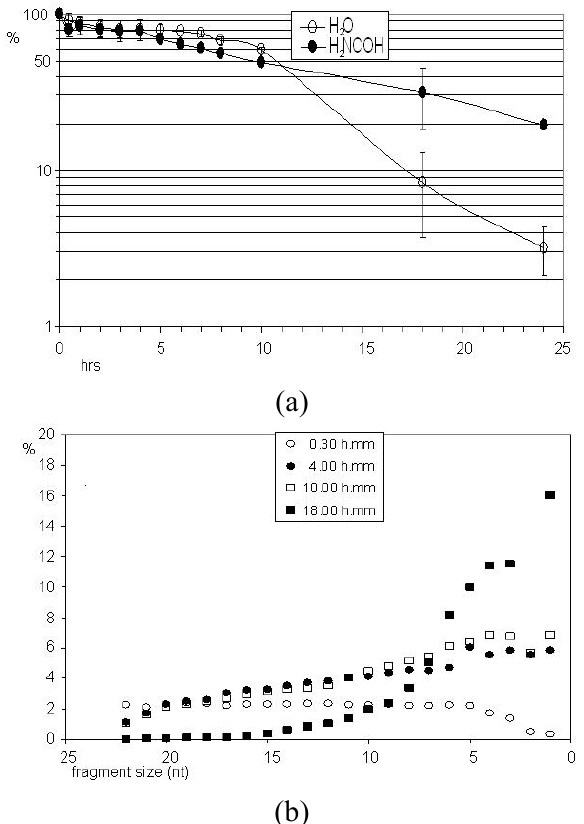
Figure 3. Quantitative analysis of the degradation of the full-length molecules reported in Figure